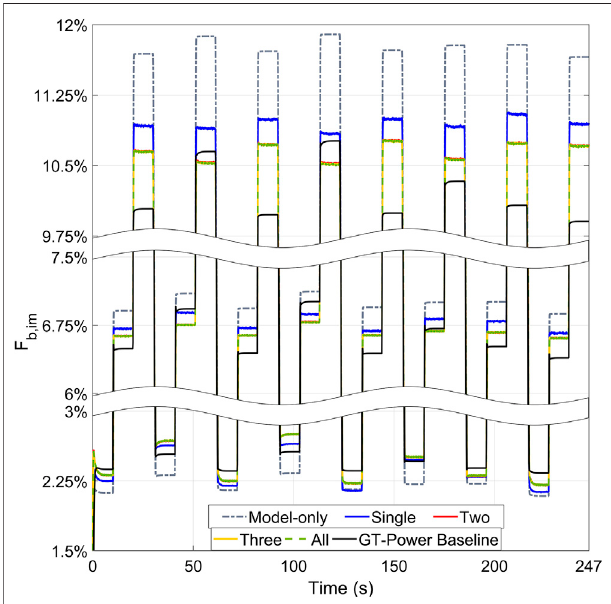
FIGURE 14 | Intake manifold burnt gas mass fraction estimation when using optimal sensor sets.